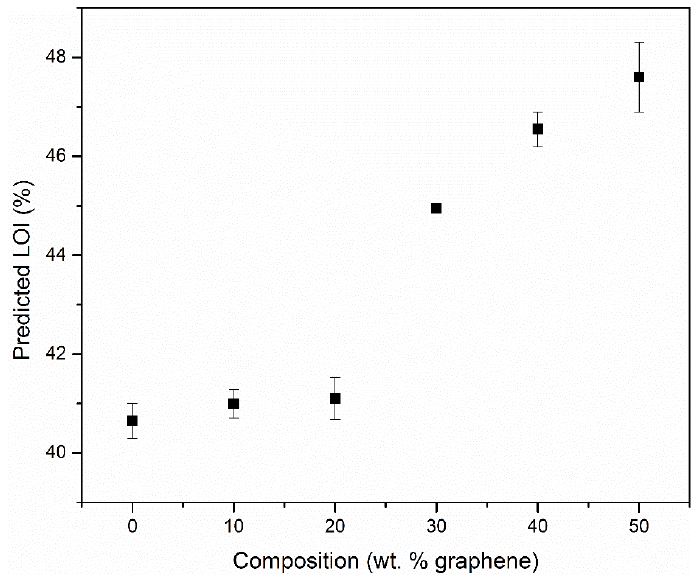
Figure 6. Predicted limiting oxygen index (LOI) versus composition for neat PI and composites containing 10, 20, 30, 40 and 50 wt.% graphene based on Equation (2) ([28]). Based on the approximations obtained from Equation (4), there is a 17% improve- ment in the LOI of the neat PI with the addition of 50 wt.% graphene.